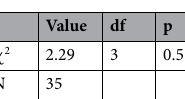
Table 3. McNemar test. df degrees of freedom, N sample